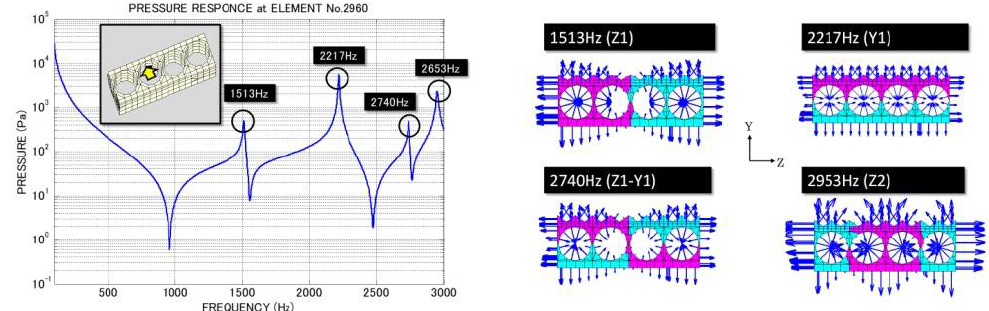
Figure 9. Acoustic characteristics of water jacket model.